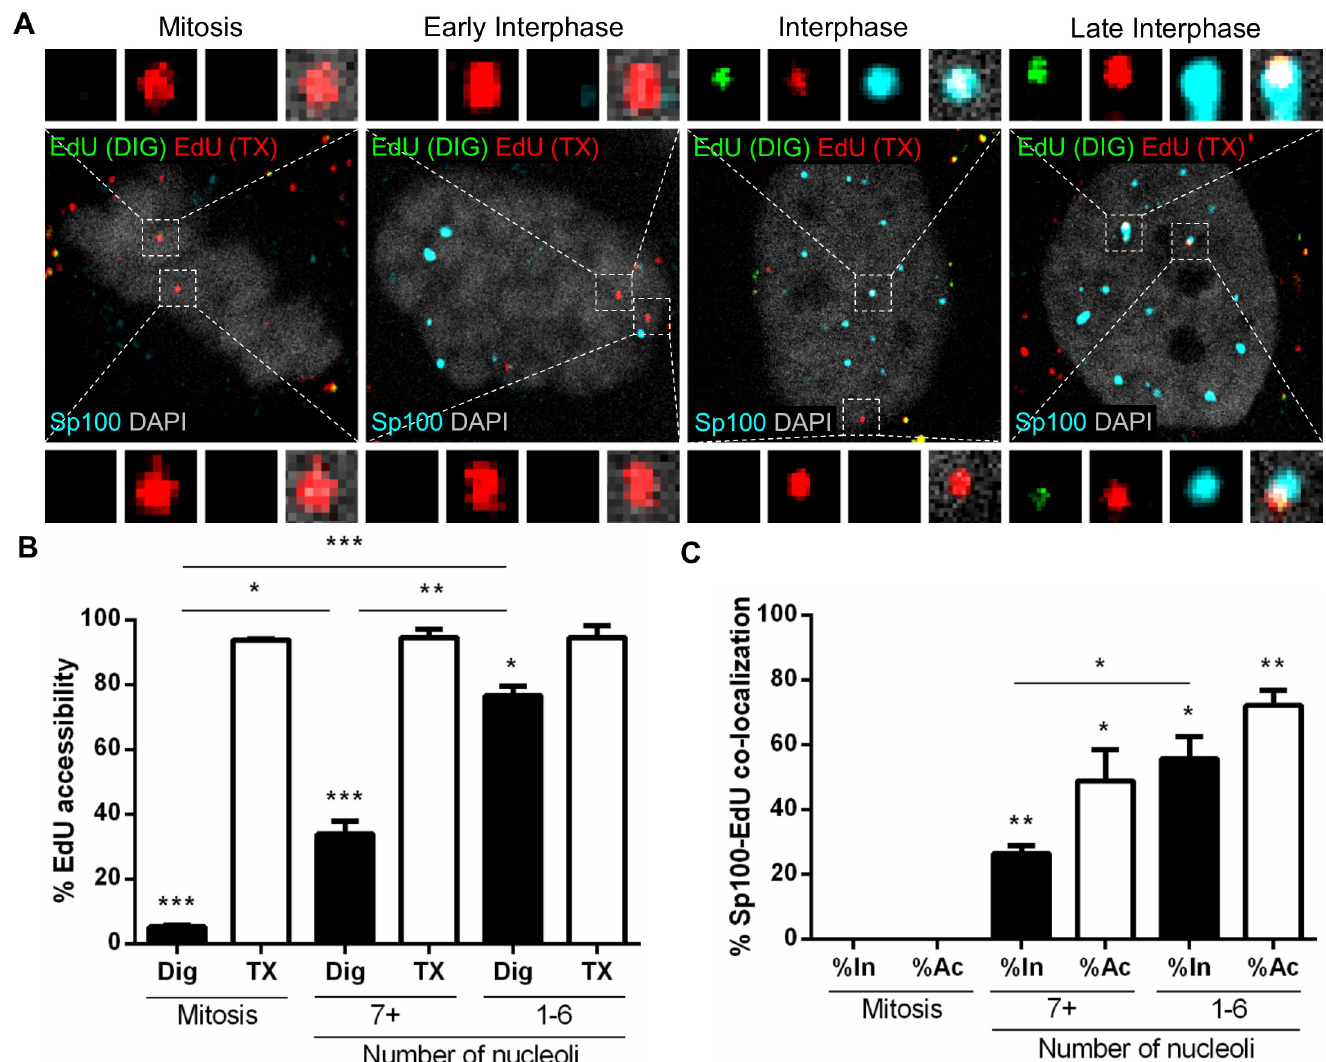
Fig 8. Sp100 is recruited after the viral genome becomes accessible to small molecular dyes. (A) HaCaT cells were infected with EdU-labeled PsVs for 24 h, fixed, permeabilized with 0.625 μ g/mL digitonin and treated with AF555 (green) in Click-iT reaction buffer. Next, the cells were permeabilized again with 0.5% TX-100 and treated with AF647 (red) in Click-iT reaction buffer. Lastly, cells were incubated with rabbit anti-Sp100 antibody (cyan) and mounted with DAPI (white). (B and C) Percent accessibility of viral genome (B) was determined by manually counting the number of red only (inaccessible [In]) or red/green (accessible [Ac]) EdU puncta over the total number of EdU puncta associated with condensed chromosomes in mitotic cells or nuclear-localized in interphase cells in digitonin- or TX- 100-permeabilized cells. Nucleoli were also counted: 7+ nucleoli corresponds to early interphase, 1–6 to late interphase. Co-localization of Sp100 and EdU (C) was quantified by manually counting the number of EdU puncta that co-localized with Sp100 signal over the total number of accessible or inaccessible EdU puncta associated with condensed chromosomes in mitotic cells or nuclear-localized in interphase in digitonin-permeabilized cells. Results are shown as average of 3 independent experiments and SEM, with 30–50 cells of each condition (mitotic, early and late interphase cells) collected in z-stacks spanning the whole nucleus. (B) Mitosis: Dig: %Ac = 5.22% ± 0.69%; TX: %Ac = 93.87% ± 0.38%. 7+ nucleoli: Dig: %Ac = 33.98% ± 3.89%; TX: %Ac = 94.60% ± 2.57%. 1–6 nucleoli: Dig: % Ac = 76.67% ± 2.86%; TX: %Ac = 94.59% ± 3.64%. (C) Mitosis: %In at Sp100 = 0% ± 0%; %Ac at Sp100 = 0% ± 0%. 7+ nucleoli: %In at Sp100 = 26.49% ± 2.46%; %Ac at Sp100 = 48.95% ± 9.61%. 1–6 nucleoli: %In at Sp100 = 55.79% ± 6.74%; %Ac at Sp100 = 72.22% ± 4.66%. p value was determined using Student’s t -test comparing Interphase to Mitosis. ���� : p < 0.0001. ��� : p < 0.001. �� : p < 0.01. � : p < 0.05. ns: p >